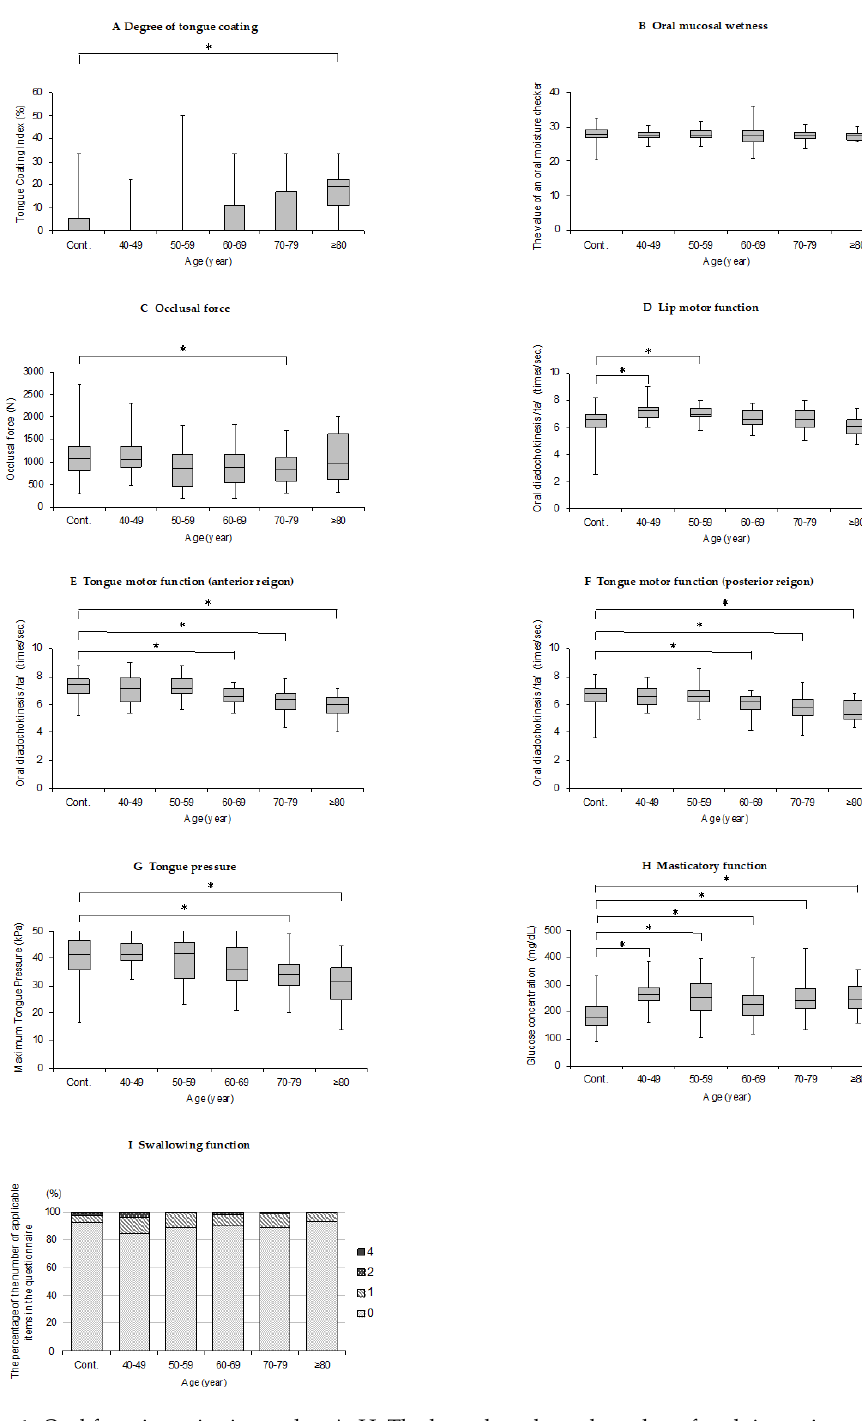
Figure 1. Oral function criteria results. A–H: The box plots show the value of each investigated criteria for each group. The horizontal line in the boxes is the median; the bottom of the box is the first quartile (25%), the top of the box is the third quartile (75%), and both ends of the mustache are the maximum and minimum values. I: The percentage of the number of applicable items in the questionnaire for each age group is shown. Asterisk (*) indicates p -value < 0.05.